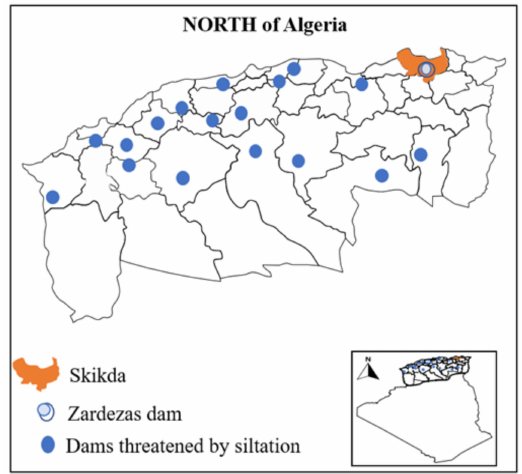
Figure 2. Zardezas dam location